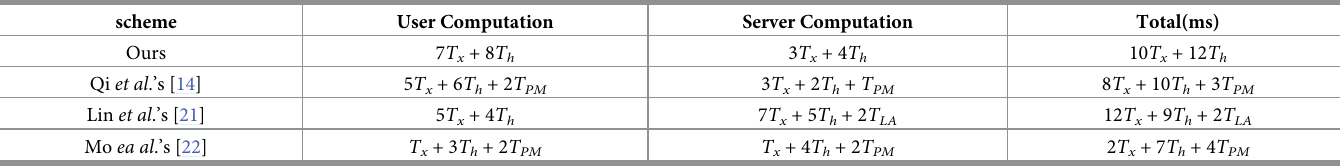
Table 4. Performance comparison in login and authentication phase.